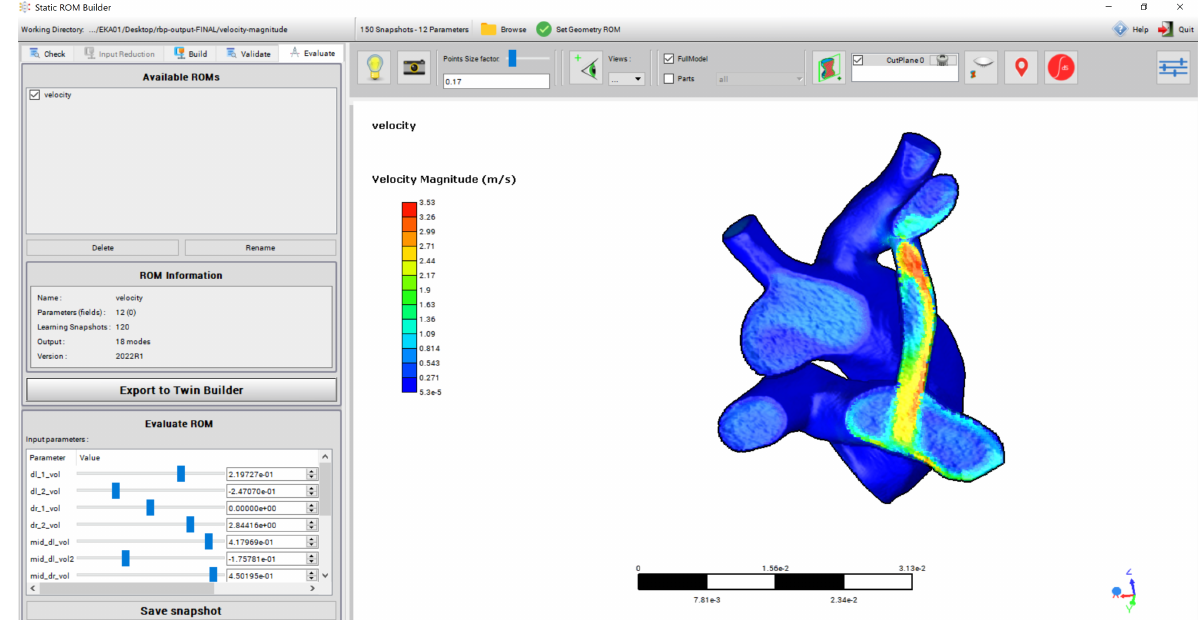
Figure 10. Visualization of the Digital Twin GUI with the interactive environment of the ROM con- sumption.